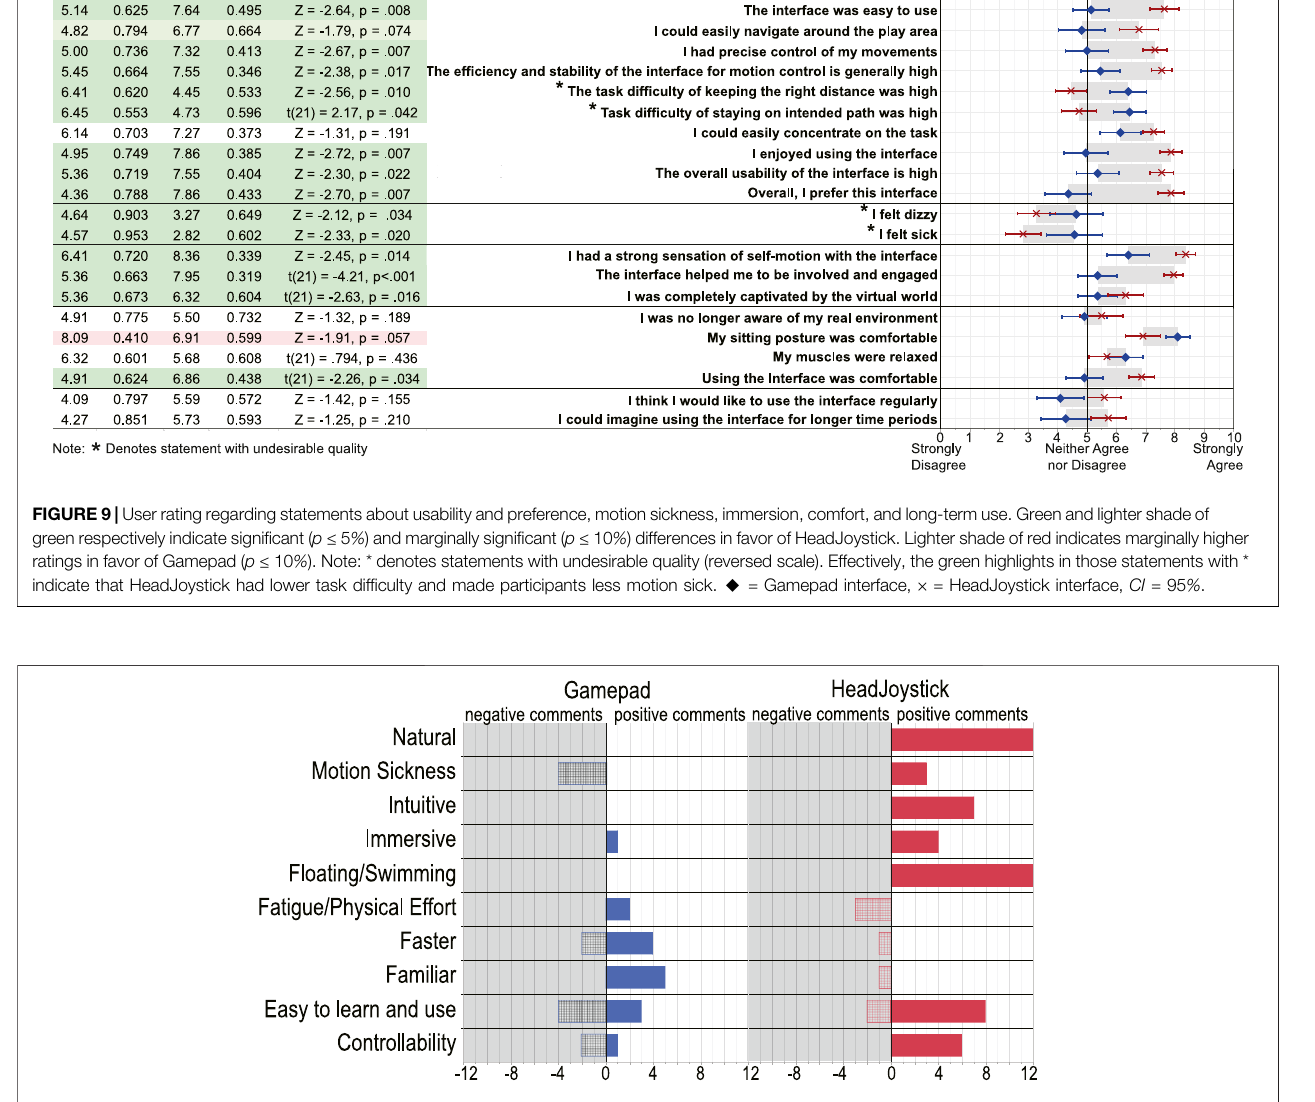
FIGURE 10 | Thematic count of participants ’ response in post-experiment interview. The x -axis represents the number of participants mentioning the themes on the y -axis. Bars to the left (gray area) correspond to the number of negative comments about that topic whereas bars to the right (white background) represent the number of positive